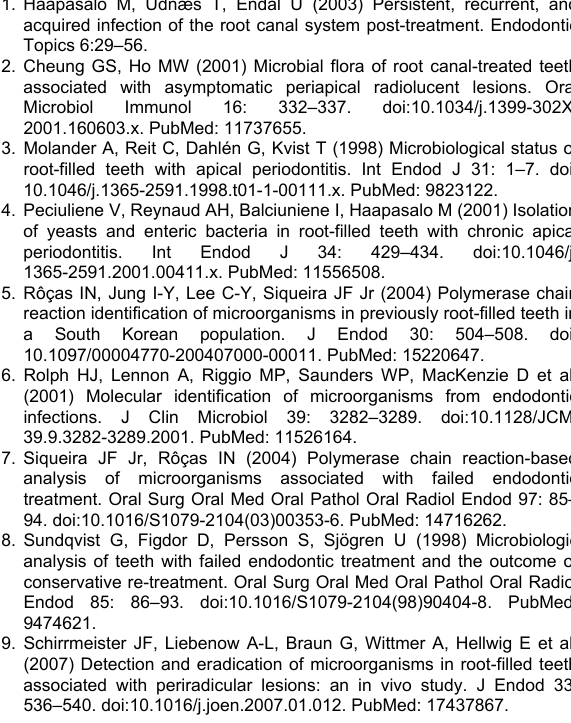
(XLSX) Figure S1. Diagram showing shared OTUs of symptomatic and asymptomatic secondary root canal infections at 3% dissimilarity (left) and 5% dissimilarity (right). (TIF) Figure S2. Diagram of rarefaction analysis of V1-V2 pyrosequencing reads of the 16S rRNA gene in samples from 40 previously filled root canals of symptomatic and asymptomatic teeth. Rarefaction values were generated at a 97% sequence similarity cut-off value by MOTHUR.